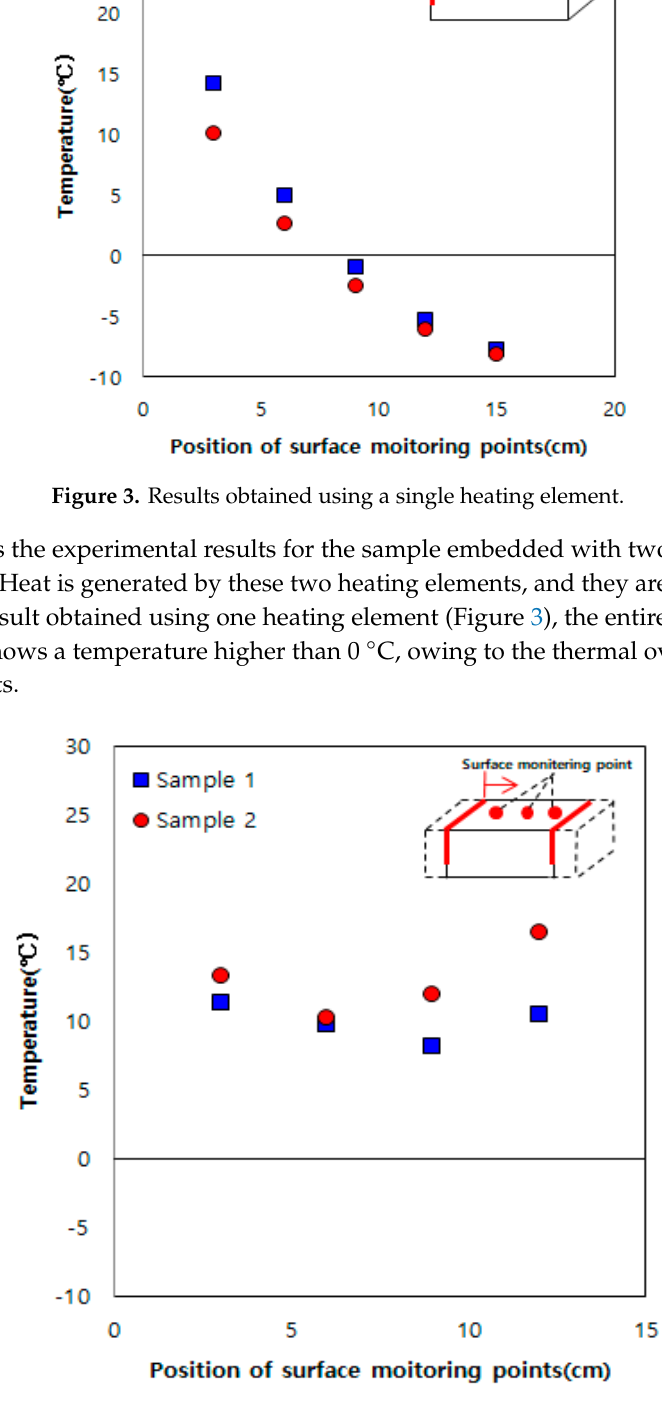
Figure 5. Results obtained using two heating elements spaced at 20 cm.